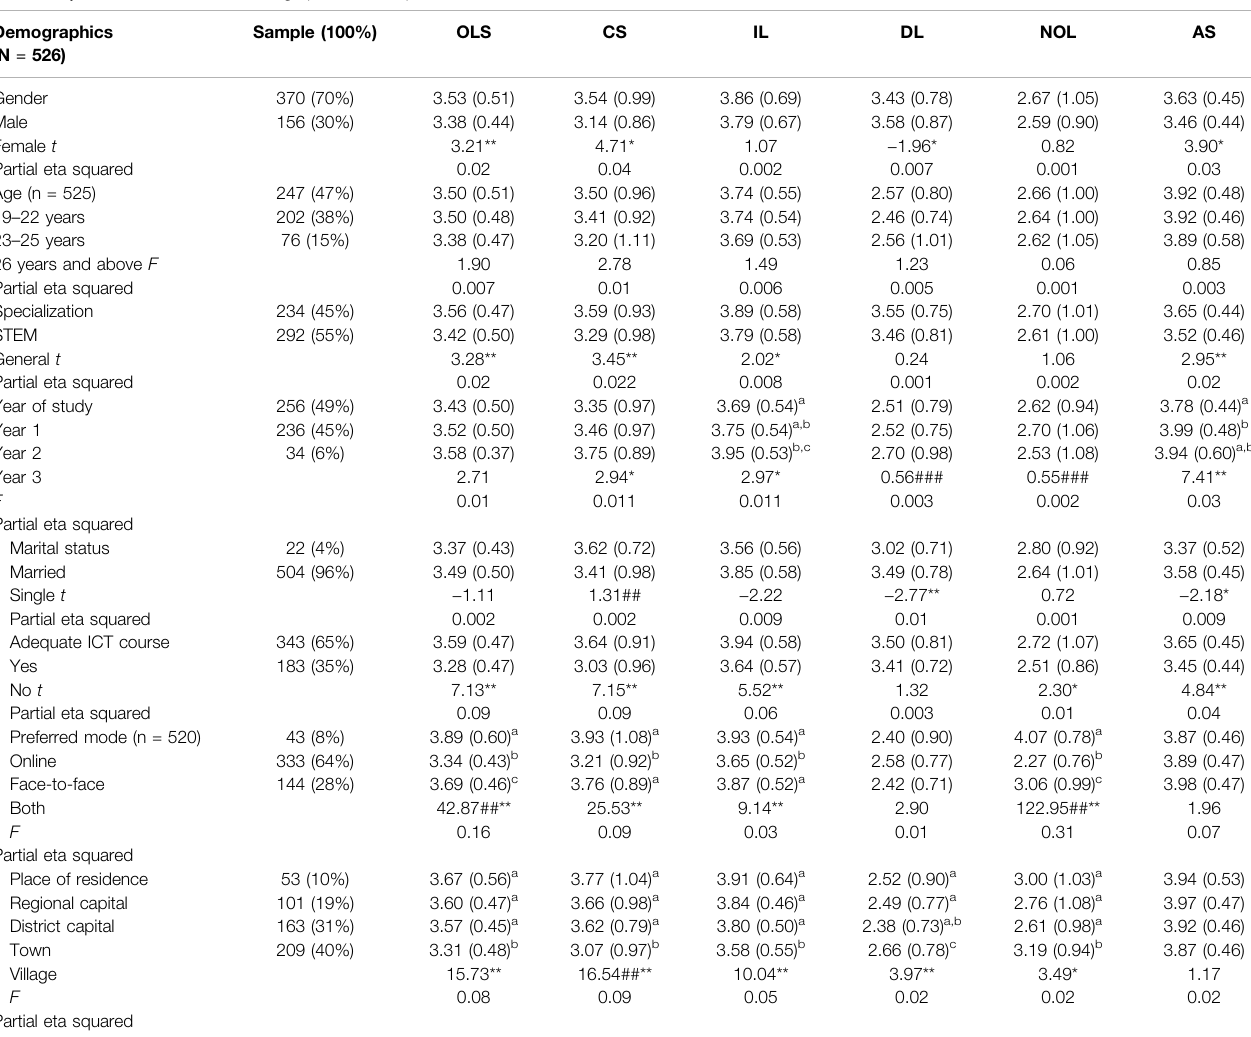
TABLE 1 | Association between demographics and dependent variables. Demographics (N = 526)